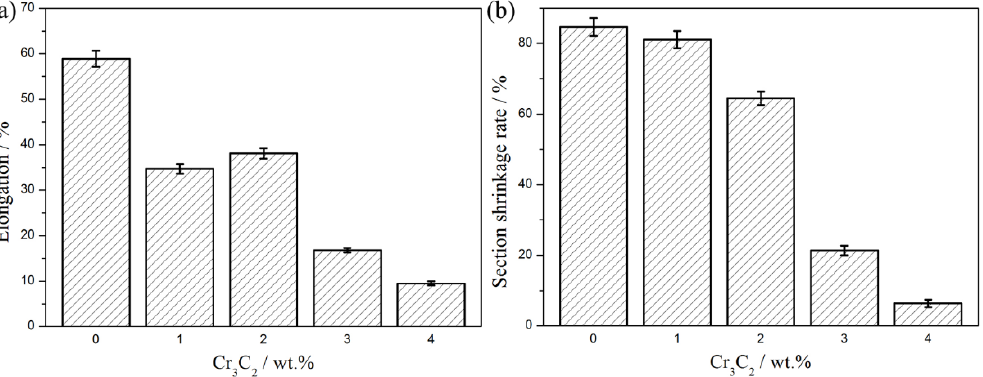
Figure 8. The elongation and section shrinkage rate of the Cr 3 C 2 particle-reinforced Al matrix composite: ( a ) elongation and ( b ) section shrinkage rate.